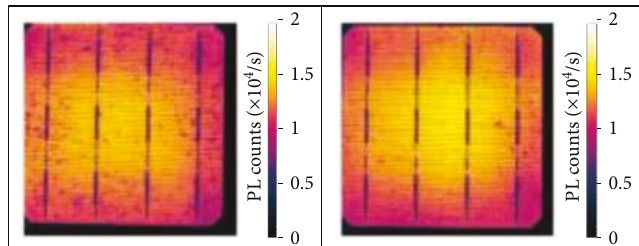
Figure 2: Photoluminescence images of two contaminated production solar cells (group 2) with many localised regions of heavily reduced PL